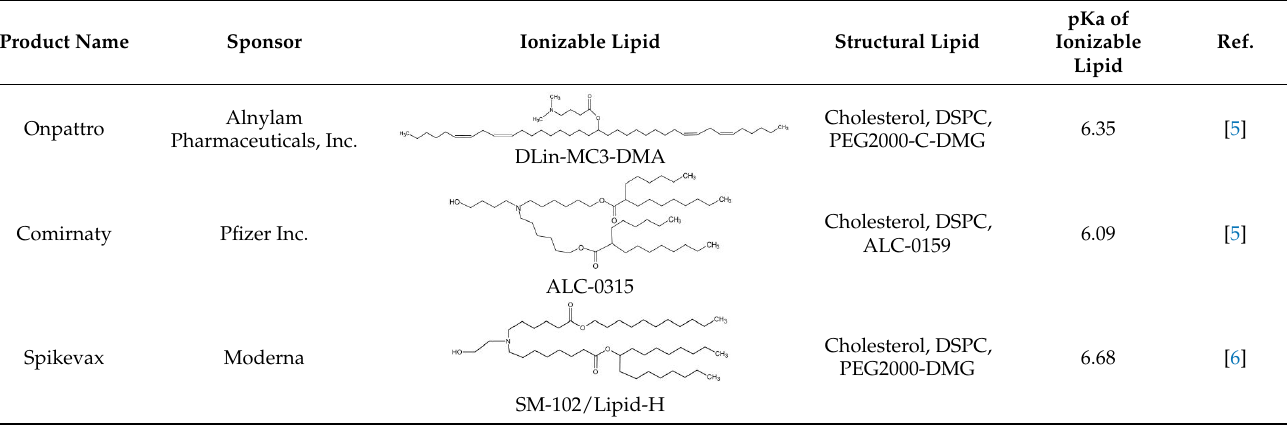
Table 2. Constituent lipid information on approved RNA LNP